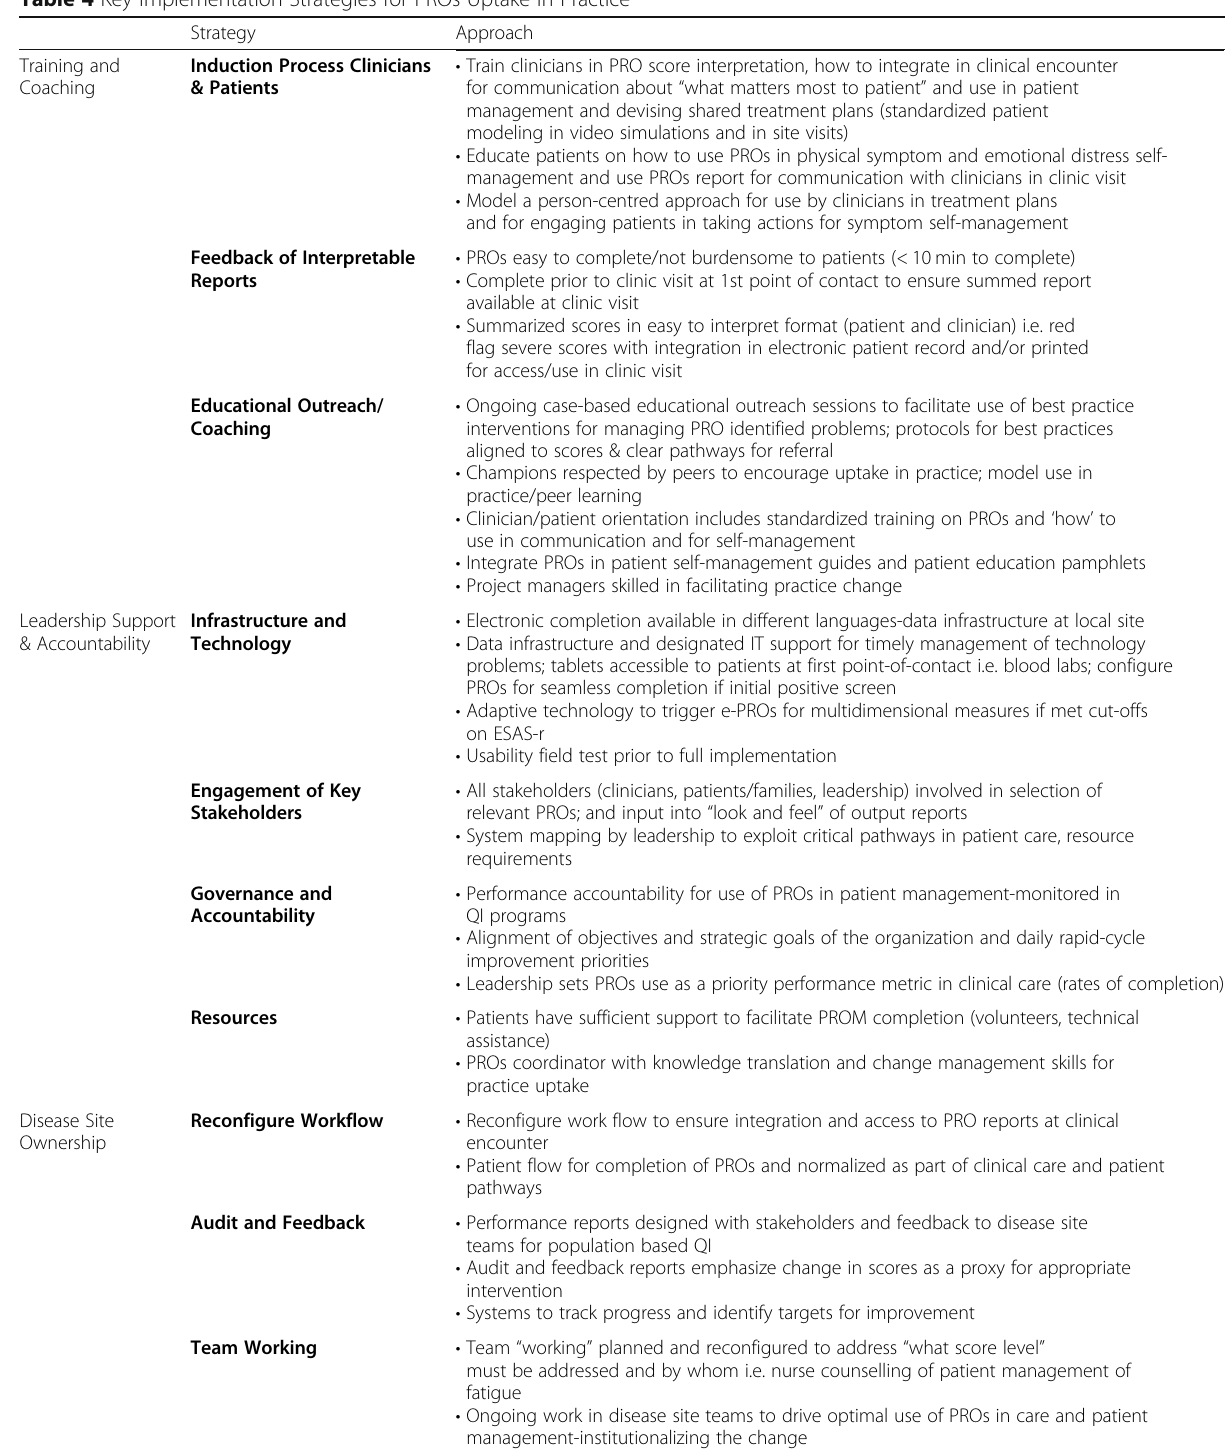
Table 4 Key Implementation Strategies for PROs Uptake in Practice